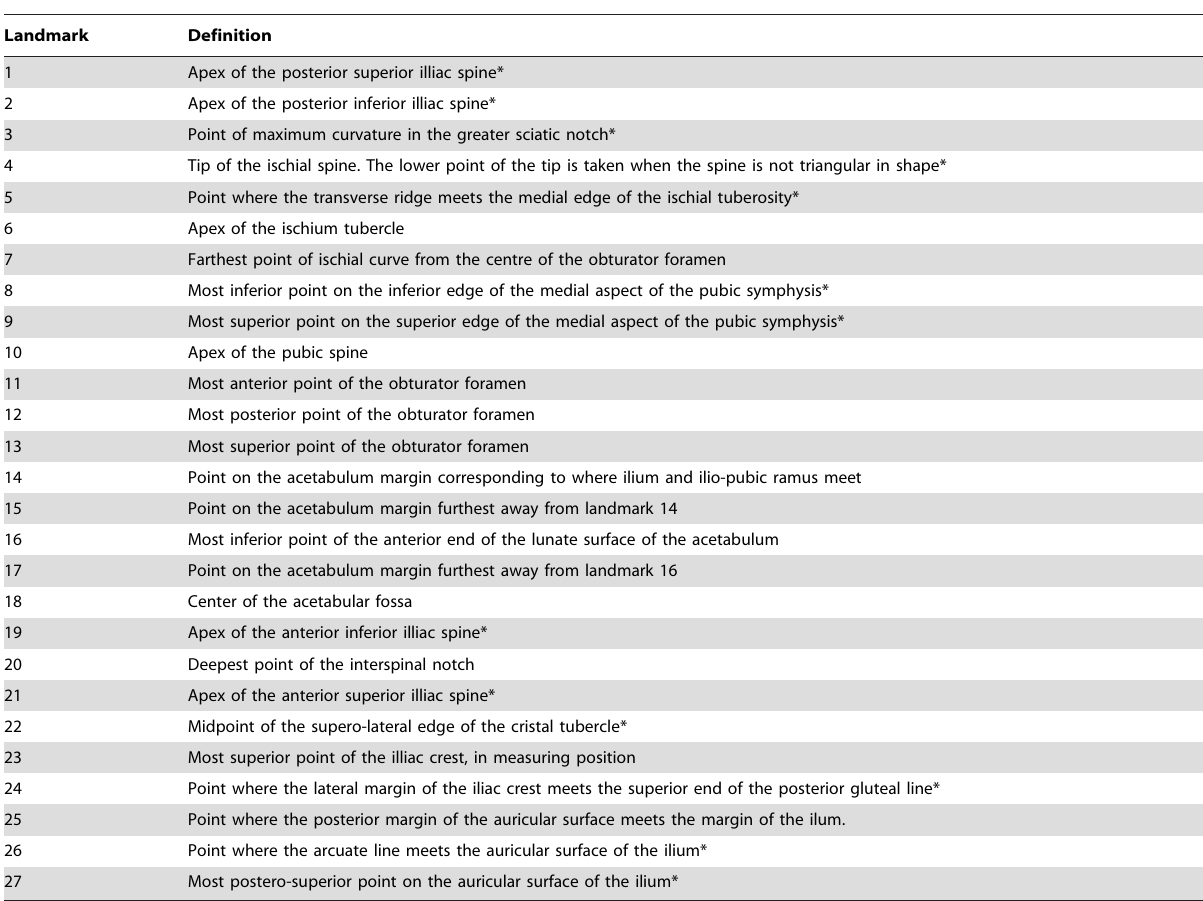
Table 2. Definition of landmarks used in this